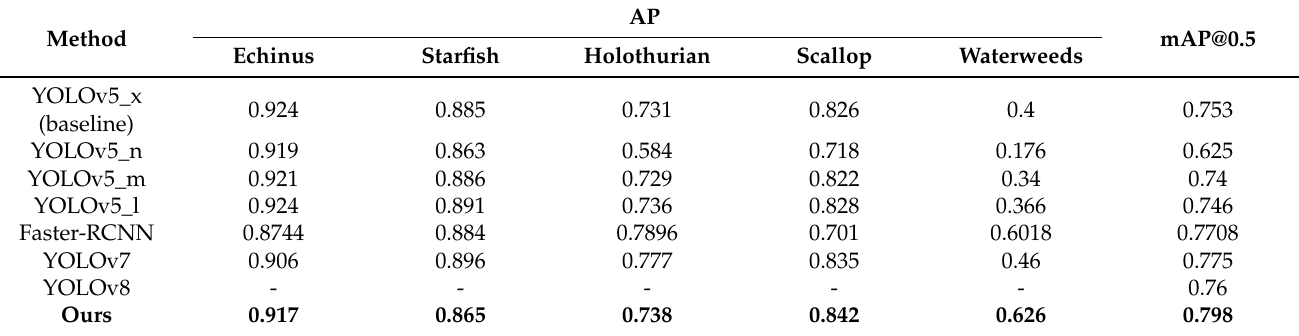
Table 2. Comparative experiments based on the URPC2019